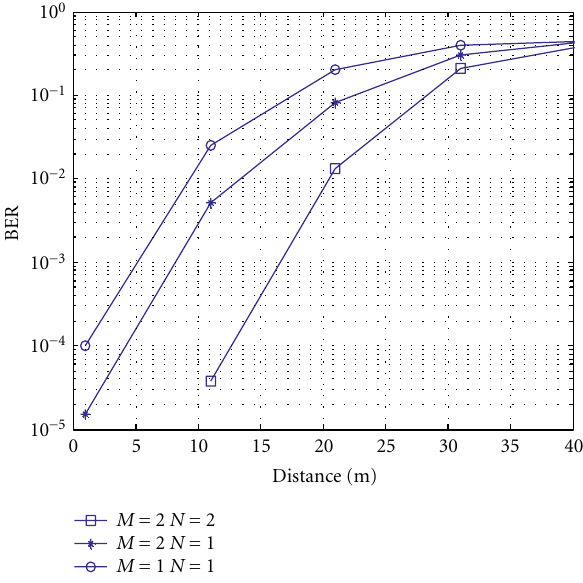
Figure 4: BER performance versus coverage range of SISO, MISO, and MIMO UWB